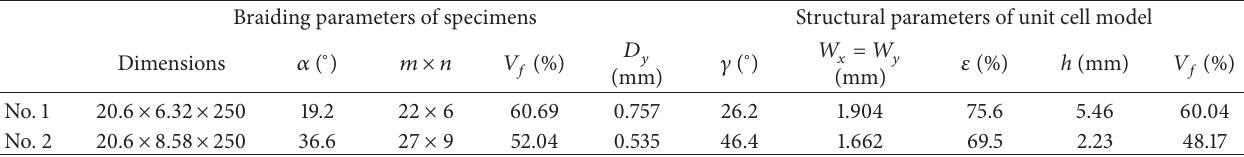
Table 3: Braiding parameters of specimens and structural parameters of unit cell